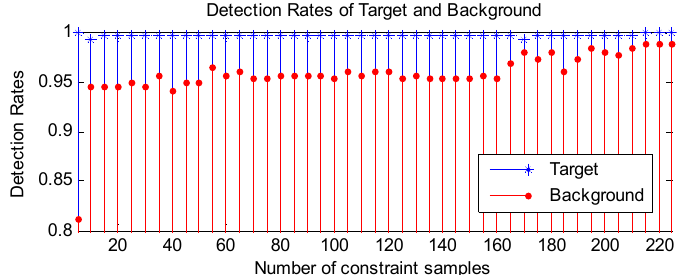
Figure 13. Detection results as the increase of constraint samples.